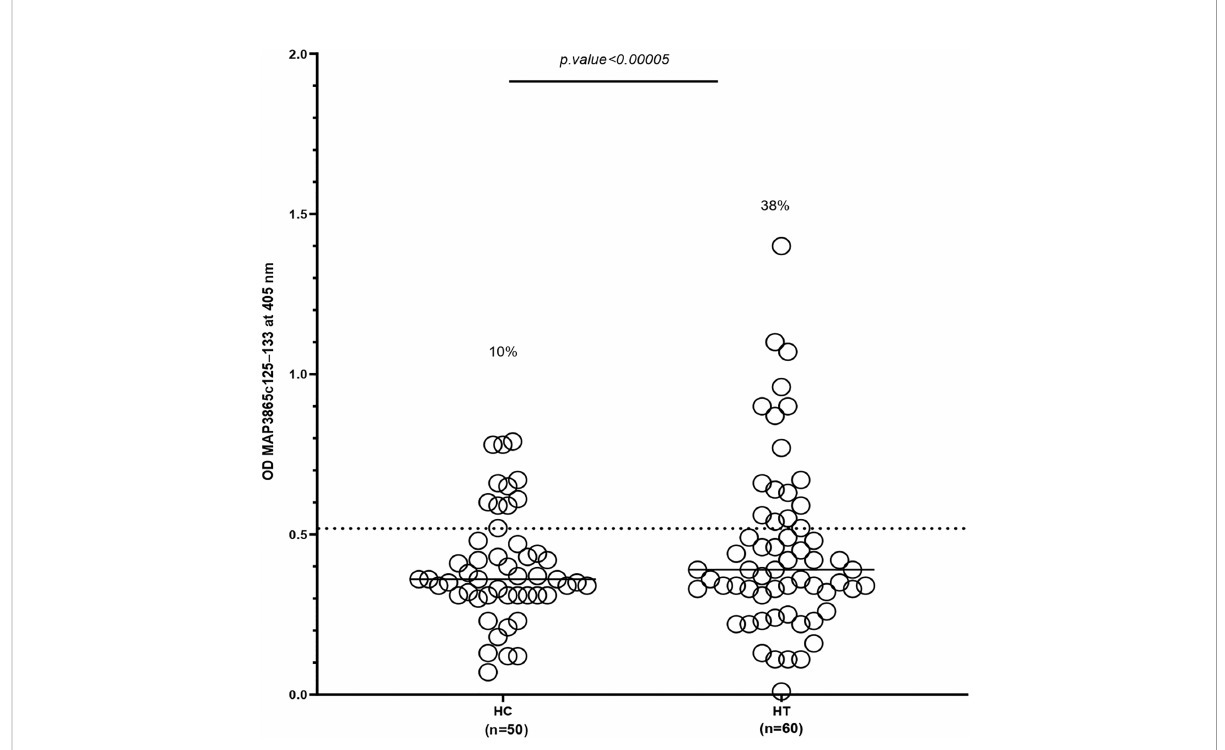
FIGURE 1 Antibody levels against MAP3865c 125 – 133 peptide in HT patients and HCs. The sera were examined in duplicate for their reactivity plate-coated MAP3865c 125 – 133 peptide. The x-axis represents the group of patients and controls, and the y-axis represents the OD for the MAP3865c 125 – 133 Abs. The dotted lines display thresholds of positivity relative to each assay (cutoff = 0.51). The percentage of Abs-positive is reported on top of each distribution. P -values (95% CI) are indicated above the graphs. HC, healthy control; HT, Hashimoto ’ s thyroids. The cutoff value was based on the receiver operating characteristic curve with 95% con fi dence